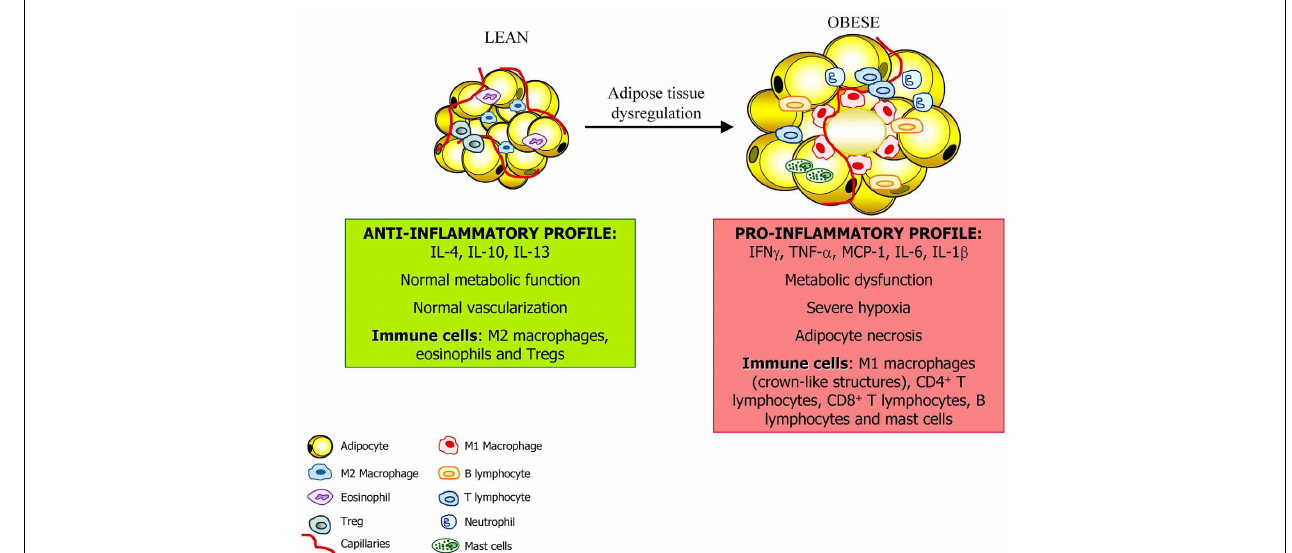
FIGURE 2 | Adipose tissue constitutes an active endocrine organ. In the lean state, adipose tissue exhibits resident macrophages polarized toward an M2 status and Treg cells involved in support a metabolic homeostasis. Moreover, the inflammation is controlled through the eosinophil-derived interleukin (IL)-4 and IL-13 as well as the IL-10 secreted by Treg cells and M2 macrophages. With a progression of obesity, adipocytes undergo